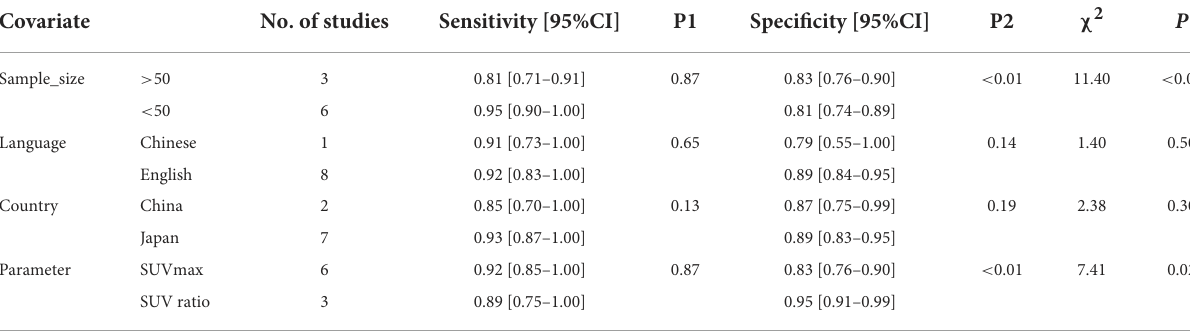
TABLE 2 Results of meta-regression analysis and subgroup